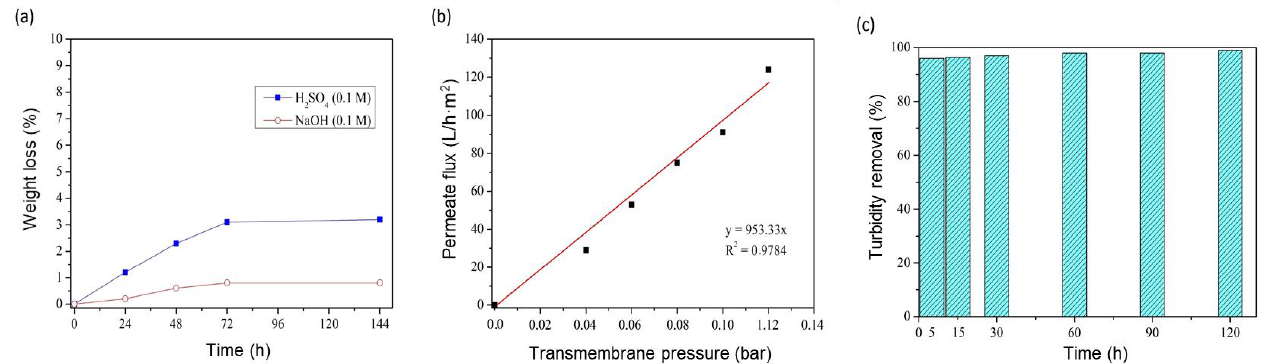
Figure 10. ( a ) Weight loss of the phosphate support in acidic and basic media; ( b ) variation of the water permeate flux of the phosphate support as a function of the transmembrane pressure; ( c ) turbidity removal of the phosphate support as a function of time.